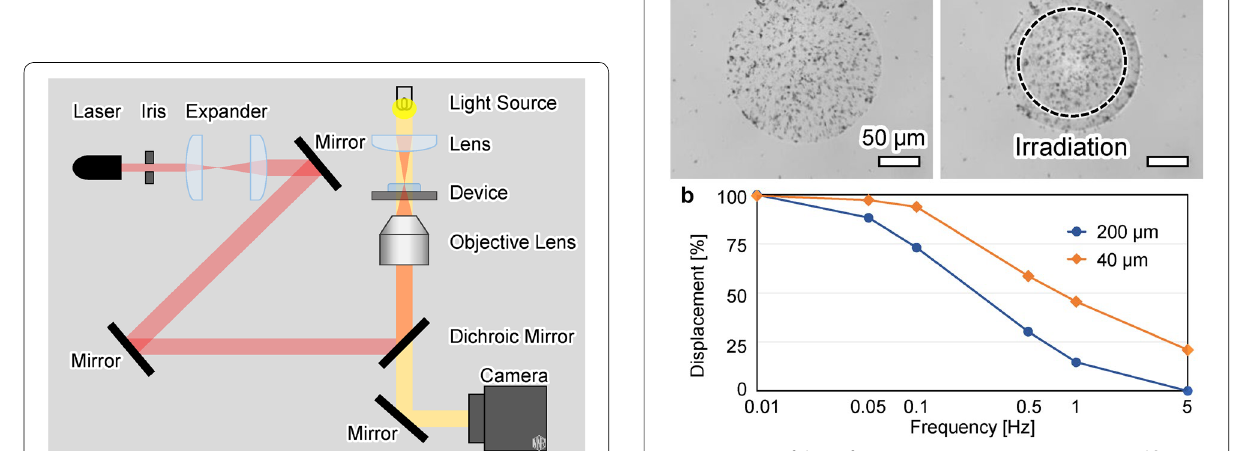
Fig. 4 Driving of the soft actuator. a Microscopic images, and b frequency